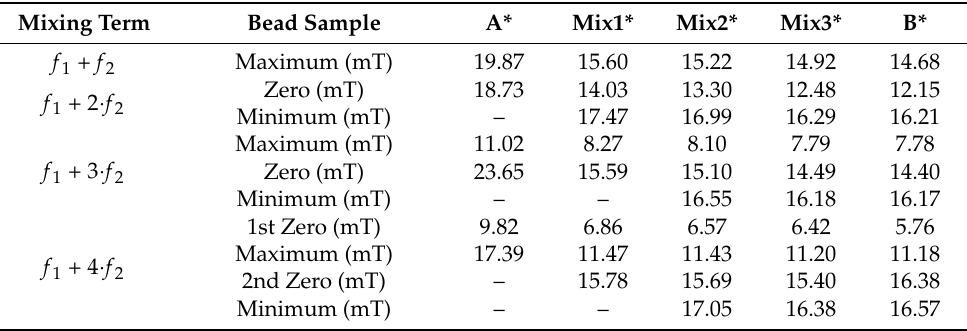
Table 3. Location of the characteristic features of reference samples A* and B* and the mixture samples Mix1* to Mix3*. Some of the parameters remained undetermined due to the limited achievable static magnetic field, they are marked with